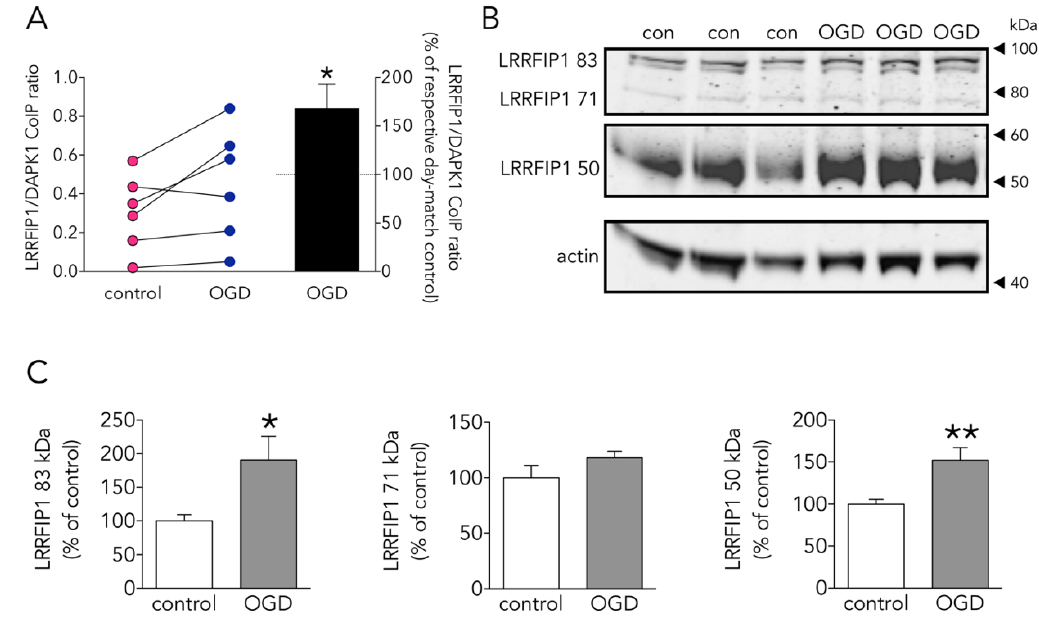
Figure 5. E ff ect of OGD on the new DAPK1-interacting candidate protein LRRFIP1. ( A ) E ff ect of OGD on the LRRFIP1 / DAPK1 co-immunoprecipitation ratio ( t test, n = 6 co-immunoprecipitations from independent primary neuron culture preparations). ( B ) WB showing the e ff ect of OGD on the expression of di ff erent LRRFIP1 transcripts, and ( C ) graphs showing the quantification of this e ff ect (83 and 50 kDa graphs: t test, and 71 kDa graph: Mann-Whitney U test, n = 3 independent primary neuron culture preparations, with 3 technical replicates each). Results in A (left panel) are shown as individual co-immunoprecipitation values, and in A (right panel) and C as the mean and SEM. * p < 0.05, ** p < 0.01 vs. respective control in all graphs.